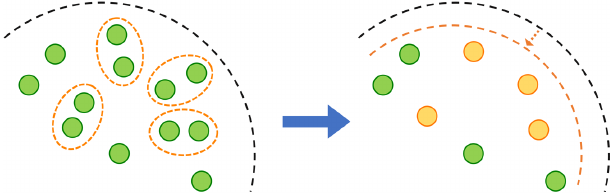
FIG. 8. RG scheme based upon repositioning atoms. Because of the finite size of the sample, if one defines the positions of the new effective atoms as being at the midpoint between the original pair, then, at each RG step, the cloud effectively shrinks, resulting in a distortion of the